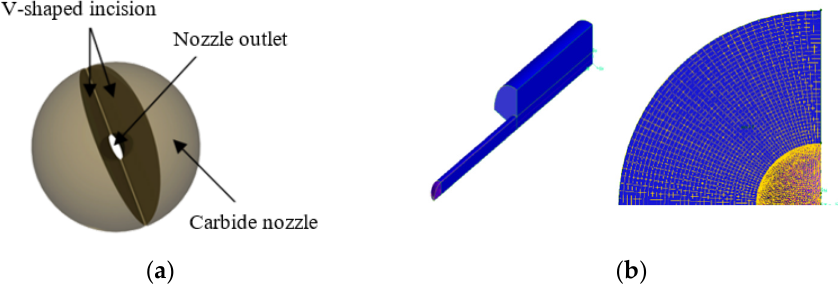
Figure 8. Internal cavity structure and meshing: ( a ) Approximate rectangular spray area nozzle structure; ( b ) Equivalent nozzle internal cavity mesh division. structure; ( b ) Equivalent nozzle internal cavity mesh